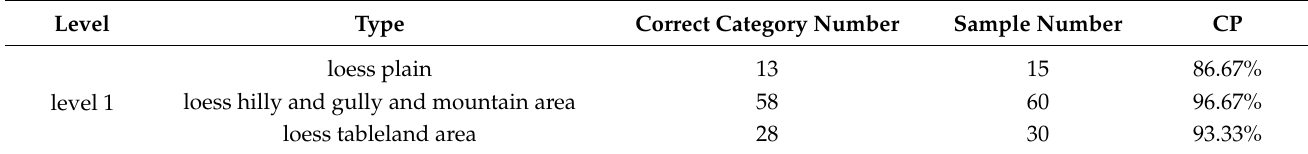
Table 3. Statistical table of the first level precision